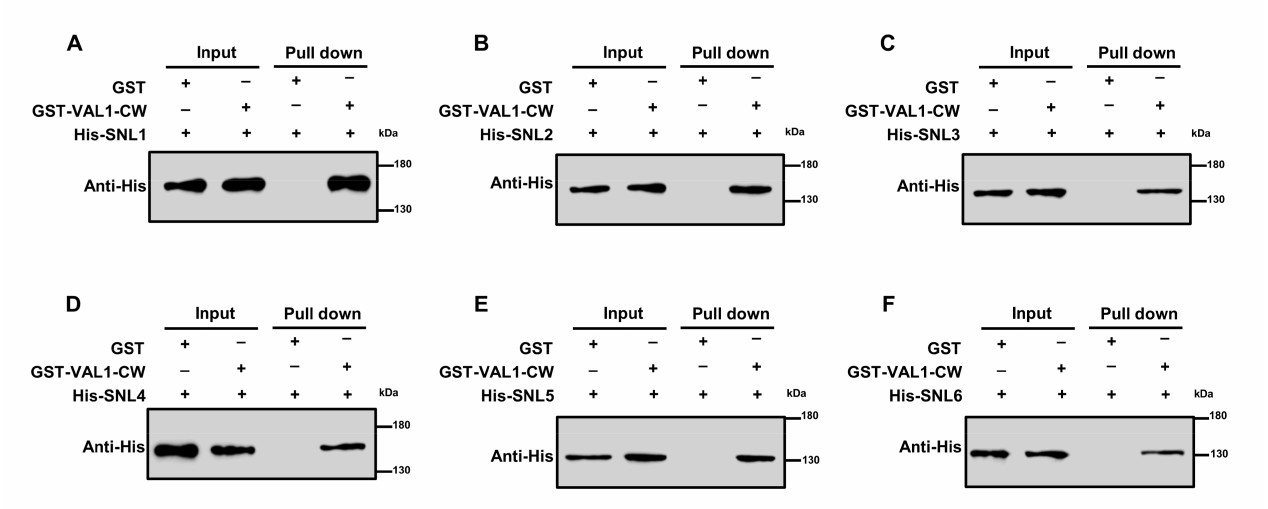
Figure 2. In vitro pull-down assay validated that the CW domain of VAL1 interacts with SNLs. ( A – F ) Induced GST-VAL1-CW (aa 458–673) or GST protein was incubated with His-SNLs (SNL1-SNL6). All protein samples were immunoprecipitated with anti-GST antibodies and immunoblotted with anti-His antibodies. The symbols “ − ”and “+” represent the absence and presence of correspond- ing